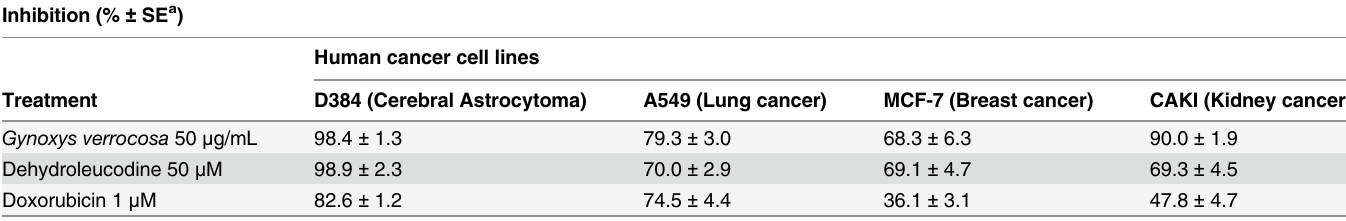
Table 1. Effect of G . verrucosa methanol extract and DhL on the growth of human cancer cell lines. Inhibition (% ± SE a